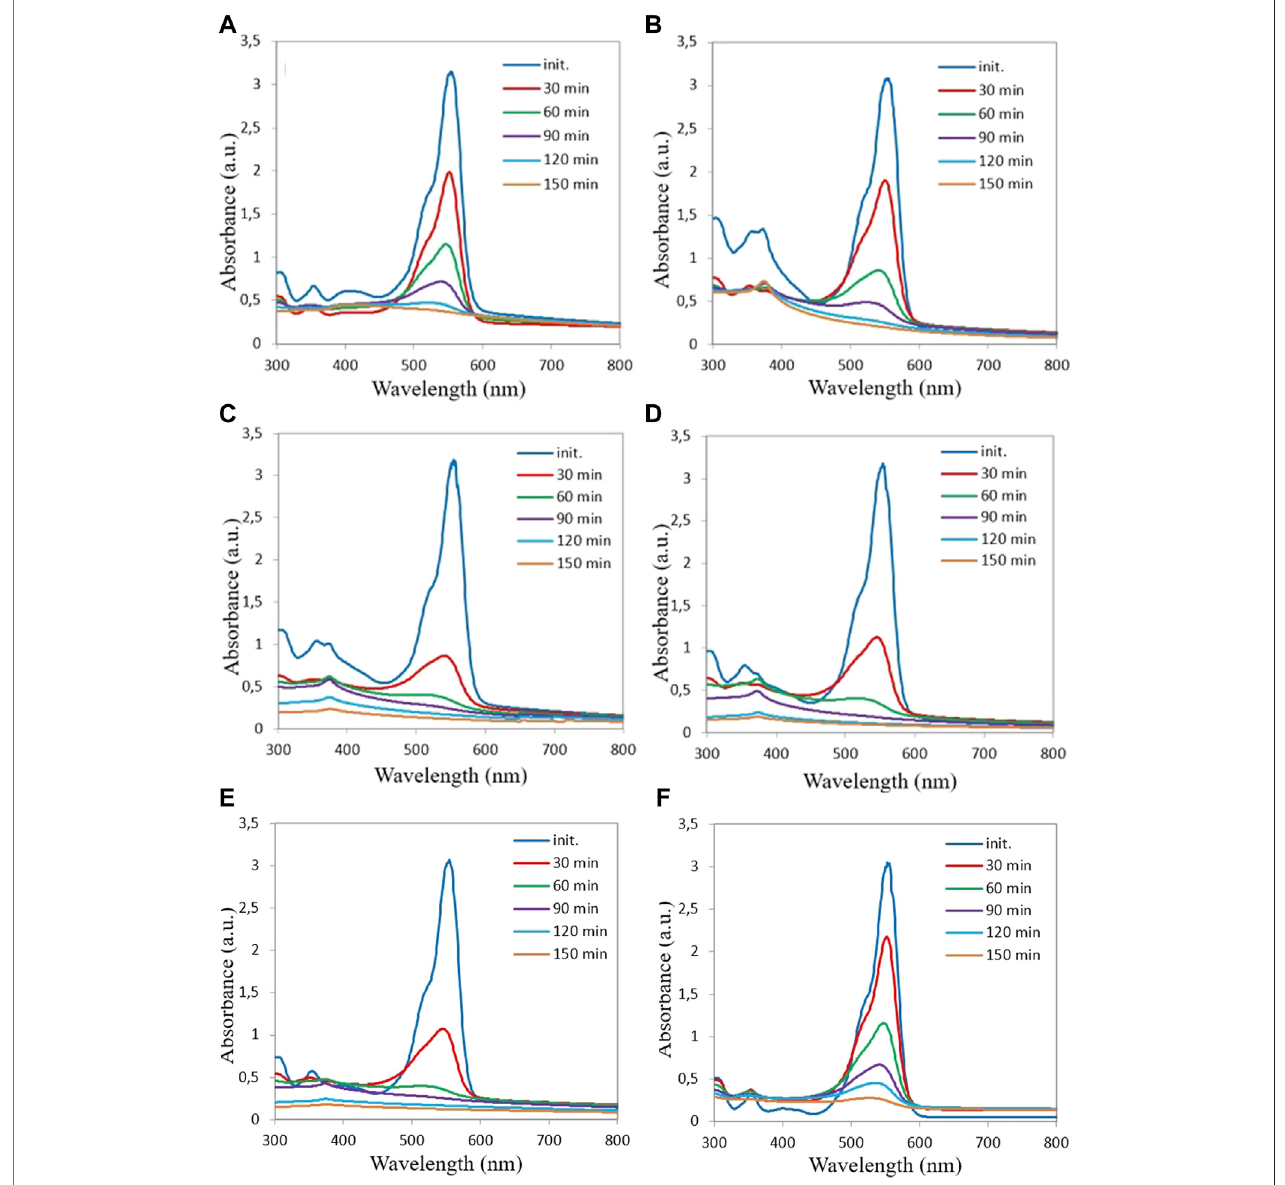
FIGURE 6 | Optical absorption spectra of RhB solutions mixed with different ZnO samples (A) ZP 20, (B) ZP 15, (C) ZP 19, (D) ZP 22, (E) ZP 26, (F) ZP 23 at increasing UV exposure time.